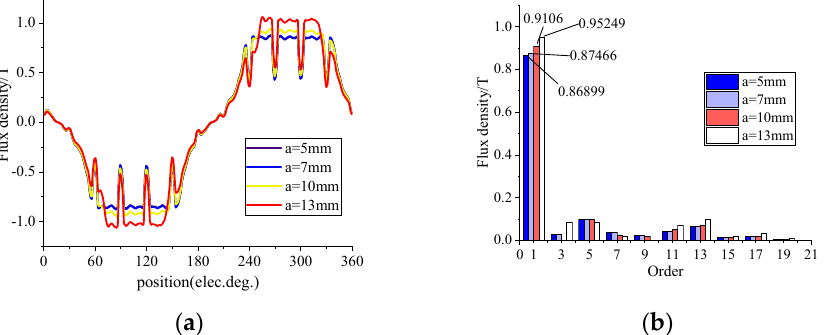
Figure 10. Air gap flux density with different barrier lengths. ( a ) Waveform of air gap flux density; ( b ) spectrum analysis.